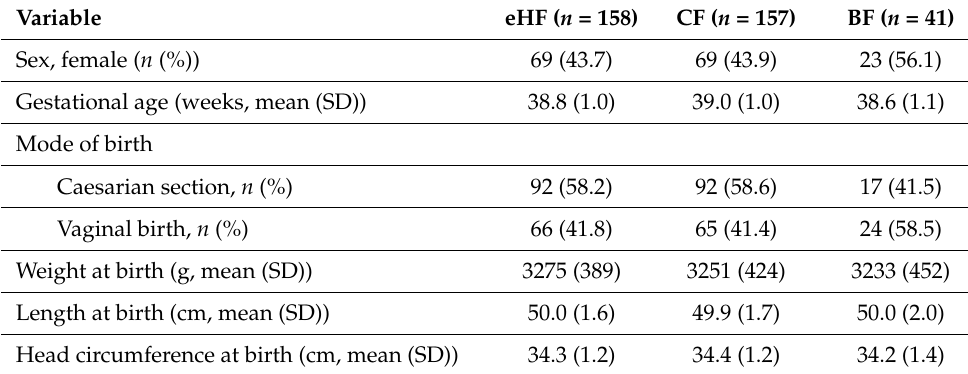
Table 2. Birth characteristics, demographic and social factors